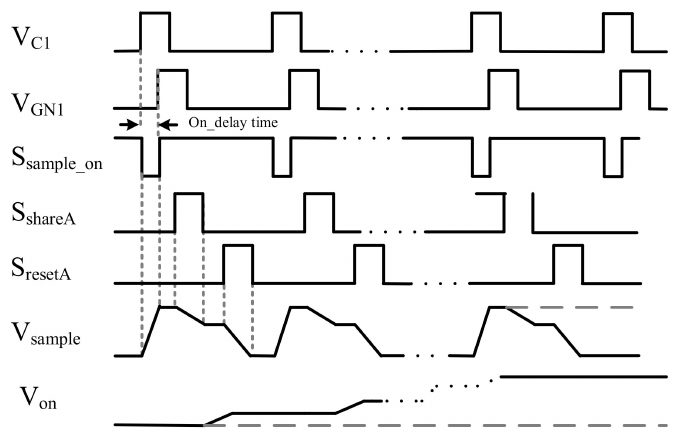
Figure 5. Timing diagram of phase error